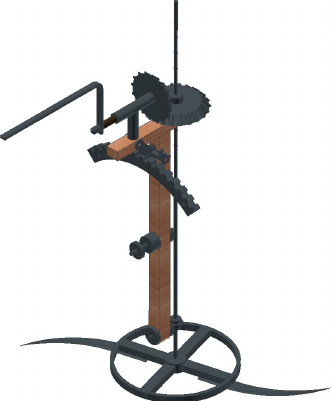
Figure 9. Axonometric view of the two-blade cutting mechanism.